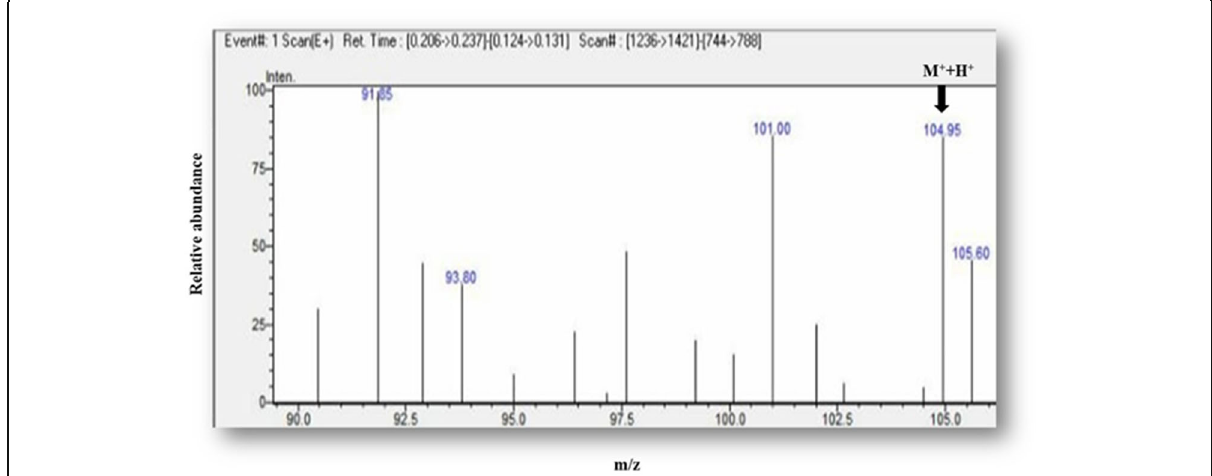
Fig. 2 Chromatogram of mass spectral analysis (m/z) for conformation of GABA produced by Lb. fermentum